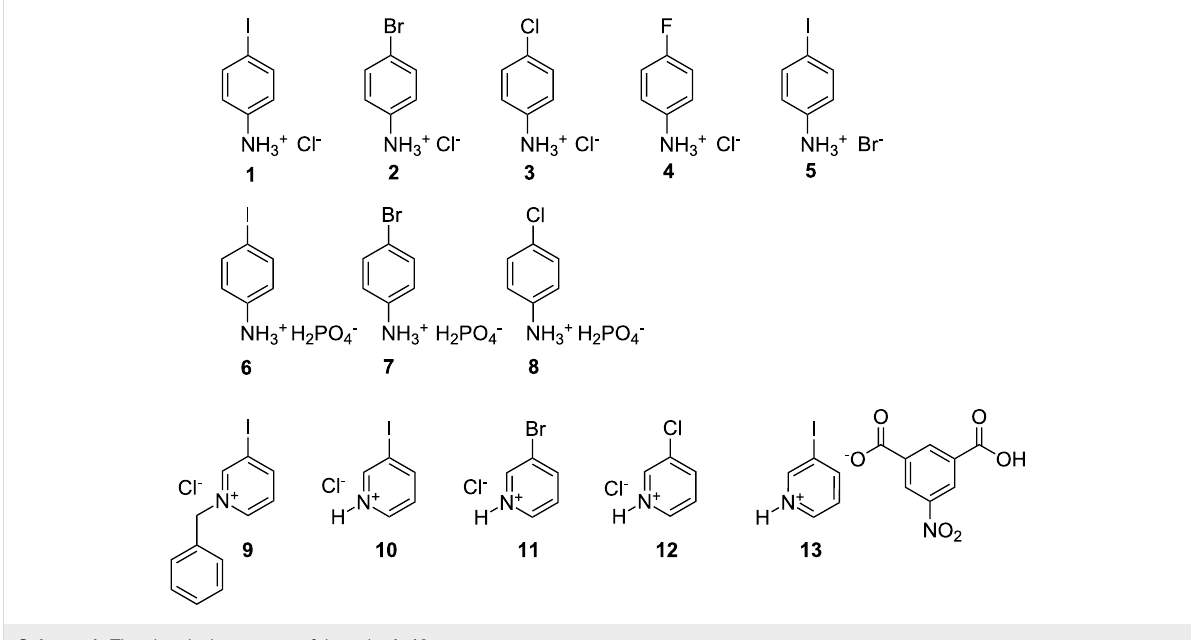
Scheme 1: The chemical structures of the salts 1–13